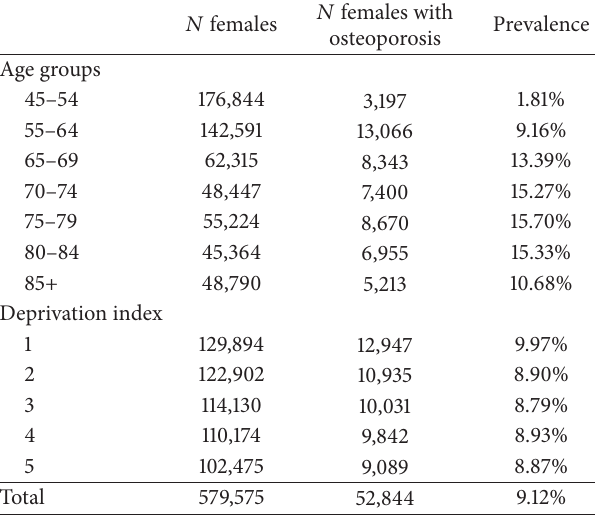
Table 1: Prevalence of chronic women with osteoporosis by age group and deprivation index.